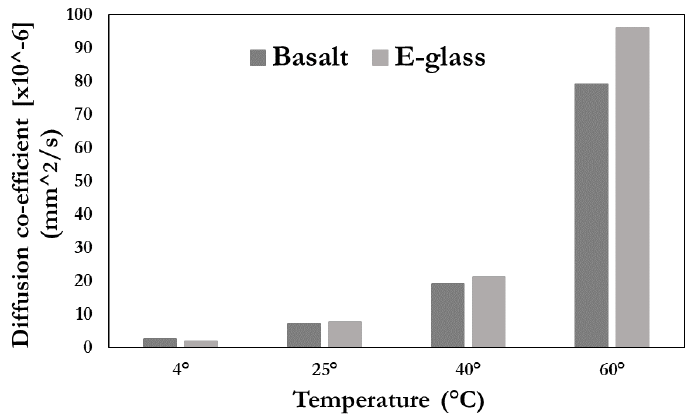
Figure 9. Comparison of D between NCF basalt/epoxy and NCF E-glass/epoxy at different temper- atures (plotted from [104]). Table 4. An overview of the variation in diffusion coefficient, D of NCF Basalt and E-glass data obtained from the literature [104] following immersion in seawater.